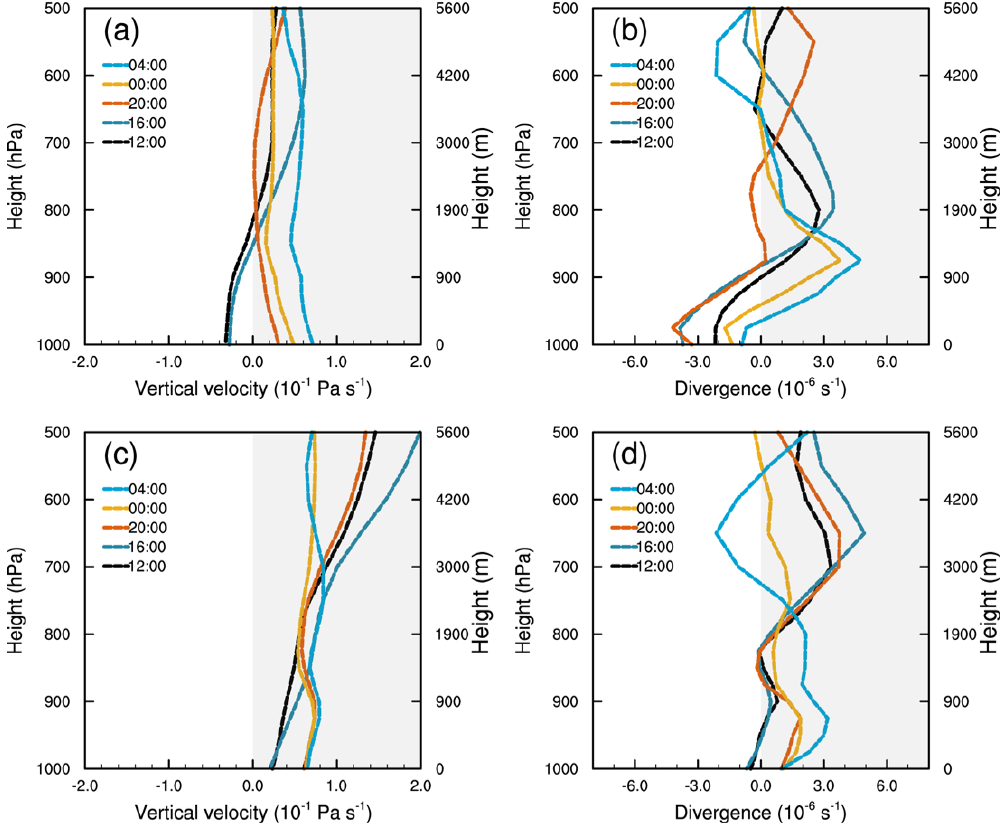
Figure 12. The averaged vertical velocity (units: Pas − 1 ; negative (positive) value denotes updraft (downward) movement) (a, c) and diver- gence (units: 10 − 5 s − 1 ) (b, d) of pollution types (a, b) and the clean type (c, d) in the North China Plain.